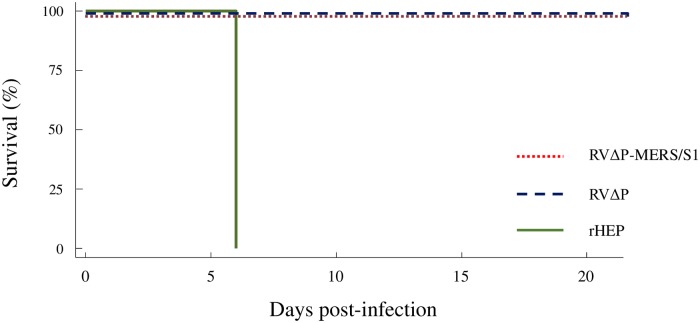
Safety profile of RVΔP-MERS/S1 in suckling mice.Four-day-old suckling mice (n = 16 in each group) were inoculated with RVΔP-MERS/S1 (red), RVΔP (blue), or rHEP (green) through intracerebral inoculation and observed for 3 weeks. All mice were inoculated intracerebrally with 20 μL of virus solutions containing 107 FFU/mL of each virus.